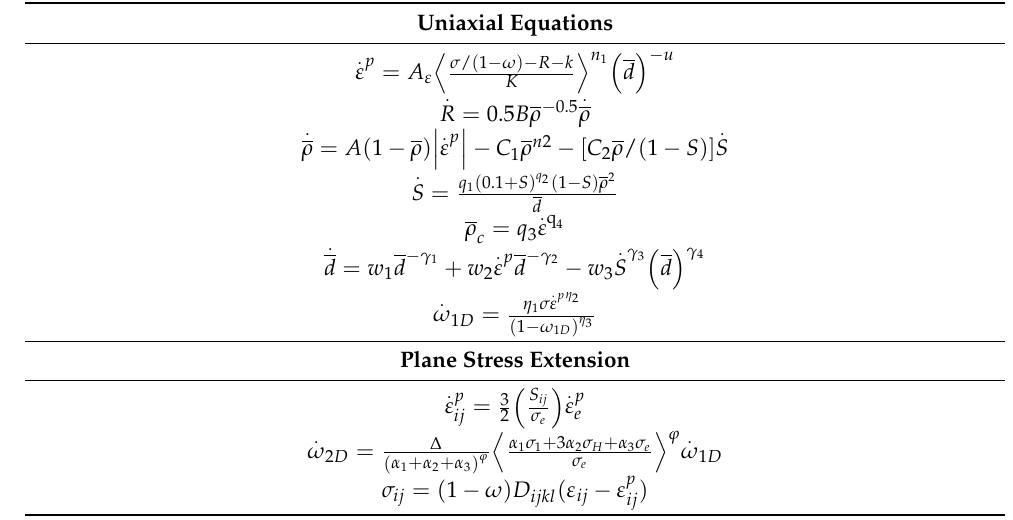
Table 2. The equation set of material